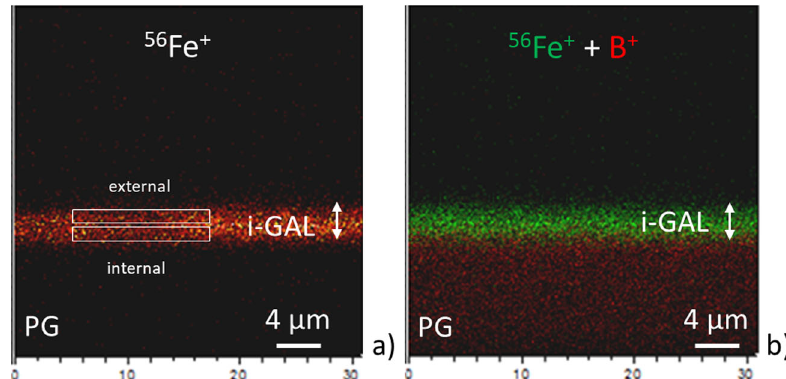
Fig. 6 ToF SIMS positive ion images obtained at the PG/i-GAL interface. ToF-SIMS image of 56 Fe + ( a ) and overlay of 56 Fe + and B + maps ( b ).